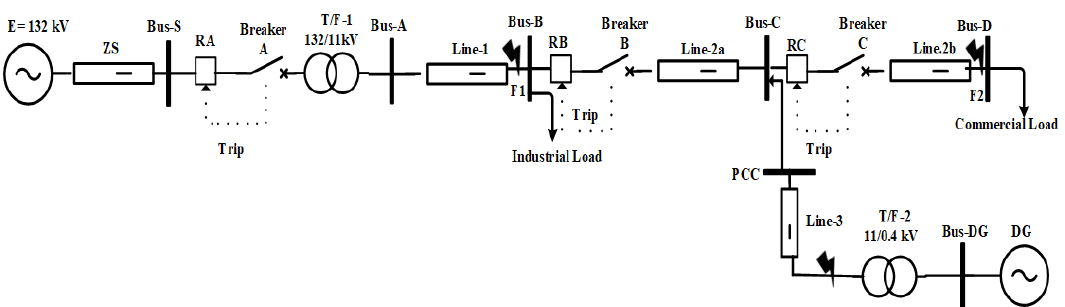
Figure 2. Single line diagram of test system under investigation.